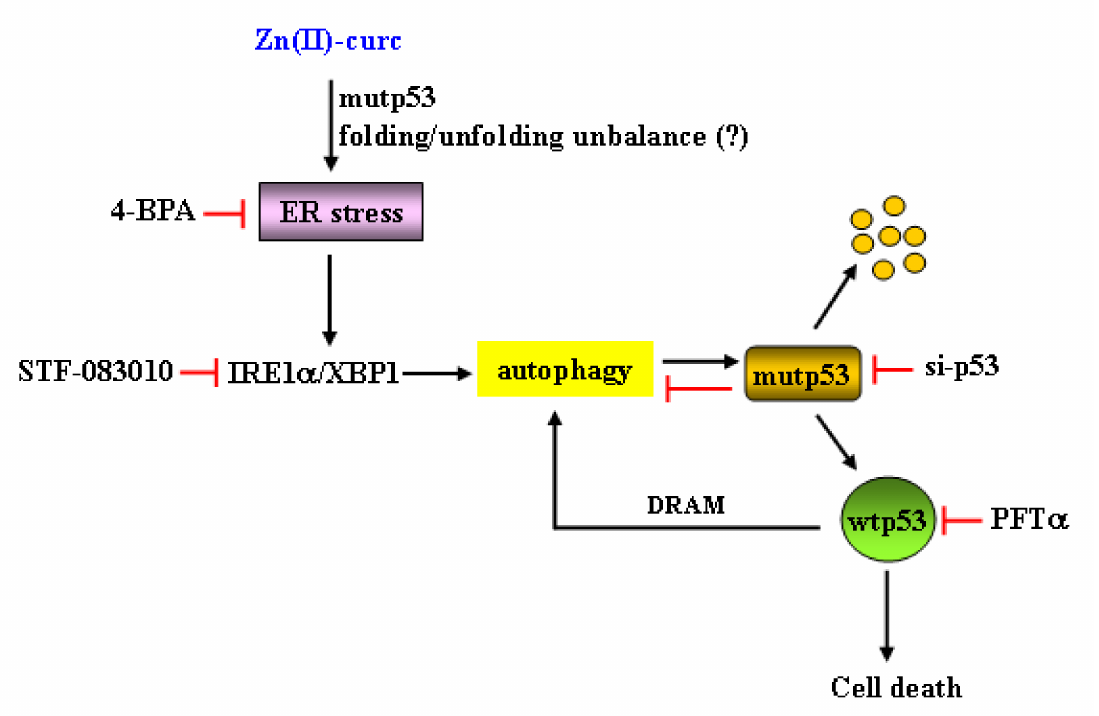
Figure 7. Schematic representation of the interplay between ER stress / unfolded protein response (UPR) activation and autophagy in response to Zn (II)-curc in mutp53H273-carrying cancer cells. Diagram illustration describes the pathways contributing to mutp53H273 degradation by autophagy and the role of ER stress / UPR activation. The arrows indicate activation, and the red lines indicate blocking. The possible starting even could be the Zn-induced mutp53 folding / unfolding balance, as previously reported